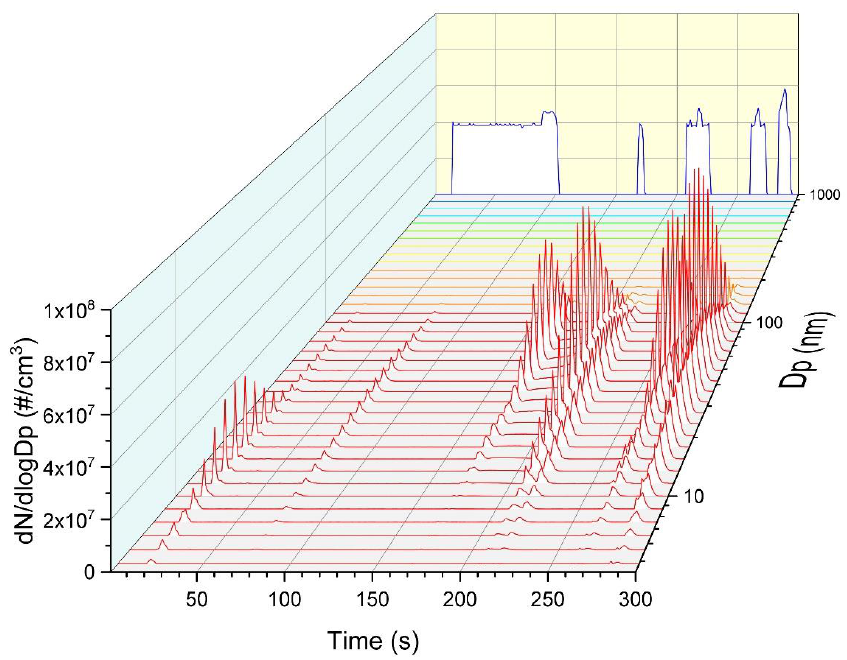
Figure 18. Transient PNSD over the first 300 s of a cold start WLTC. Engine RPM is indicated qualitatively in blue on the back wall.